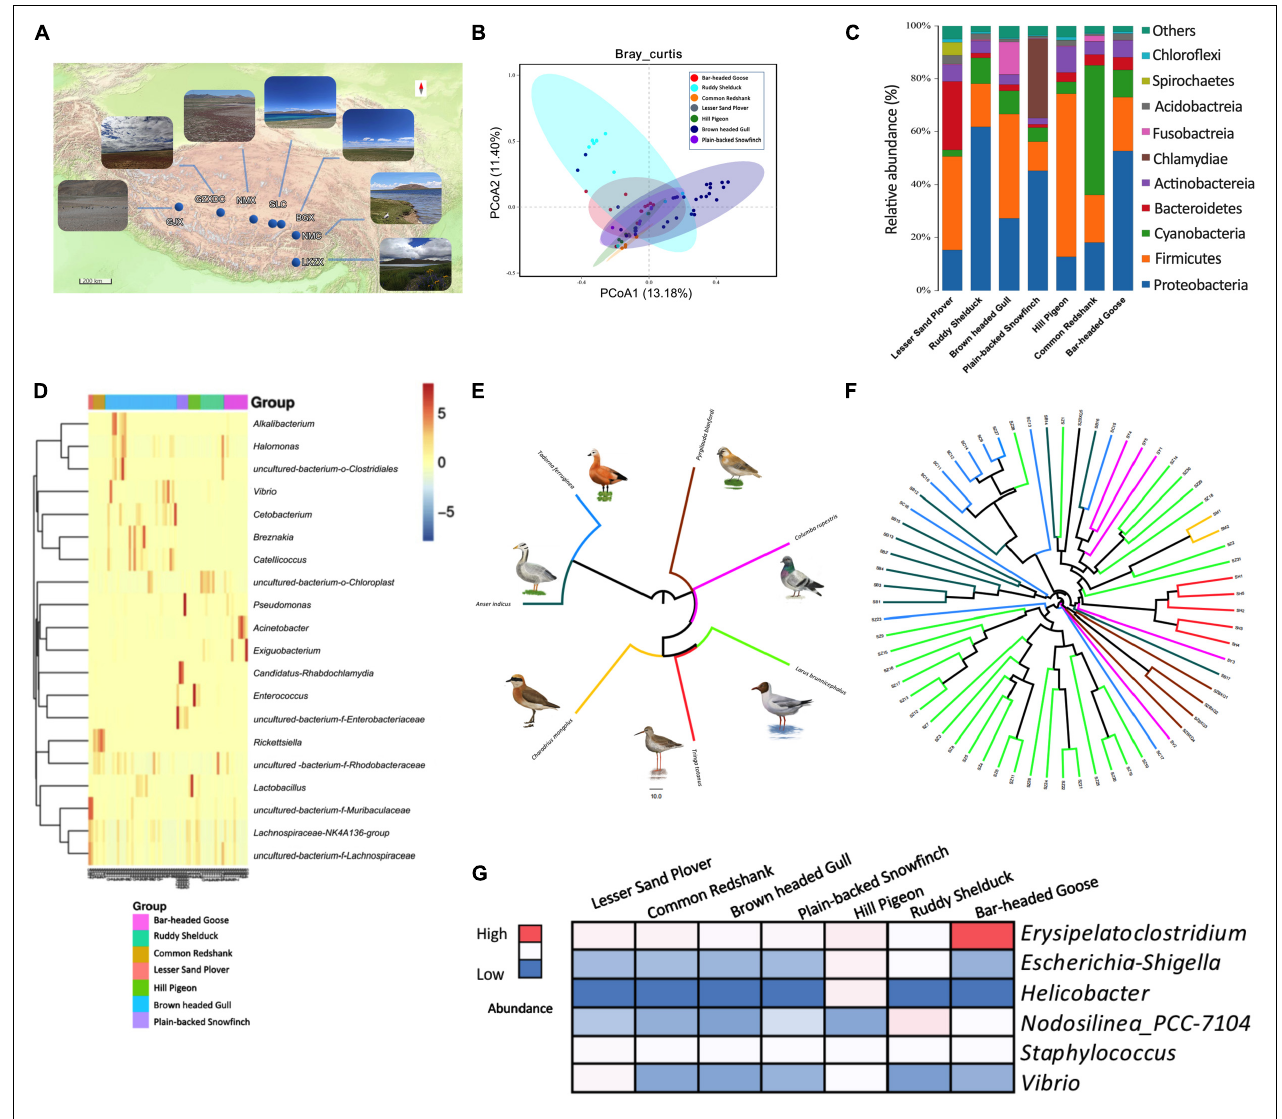
FIGURE 1 | Gut microbial diversity of birds and phylogenetic tree based on variations in complete mitochondrial gene sequences and composition of the gut microbiome. (A) Sampling location and photo record of habitats. (B) PCoA plots of Bray–Curtis distance for 67 birds. (C) Result of gut microbiota in seven species of birds at the phylum level. (D) Heat map of the microbial composition of seven species of birds at the genus level. (E) Host phylogeny based on mitochondrial genes. (F) Gut microbiome phylogeny based on Bray–Curtis dissimilarity. Branches of the same color represent the same species. The closer the samples, the shorter the branch length, indicating that the species composition of the two samples is more similar. (G) Differences in the abundance of pathogens among different